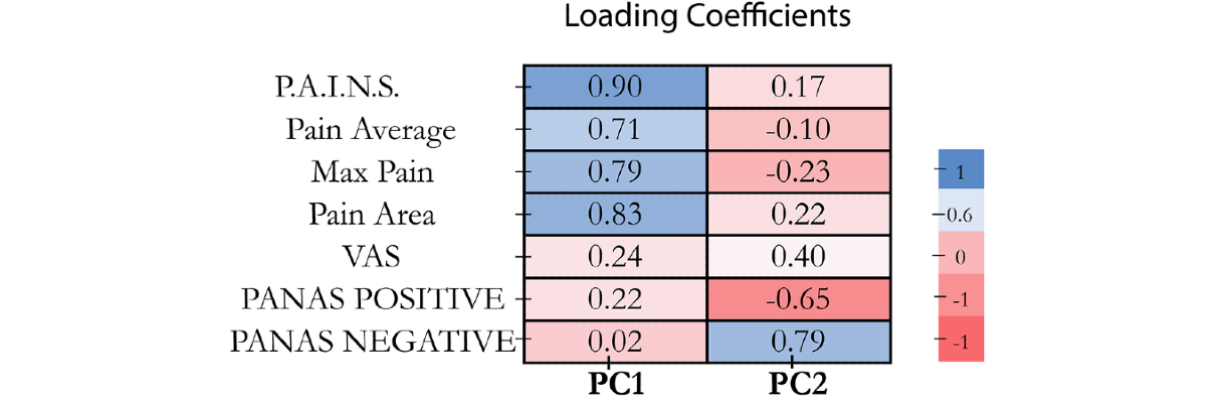
Figure 3. PC1 shows the correlation among GeoPain measures, and PC2 shows a more relevant correlation between VAS and PANAS on the baseline visit. The darker colors indicate higher loading coefficients. PAINS: pain area and intensity number summation; PANAS: positive and negative affect